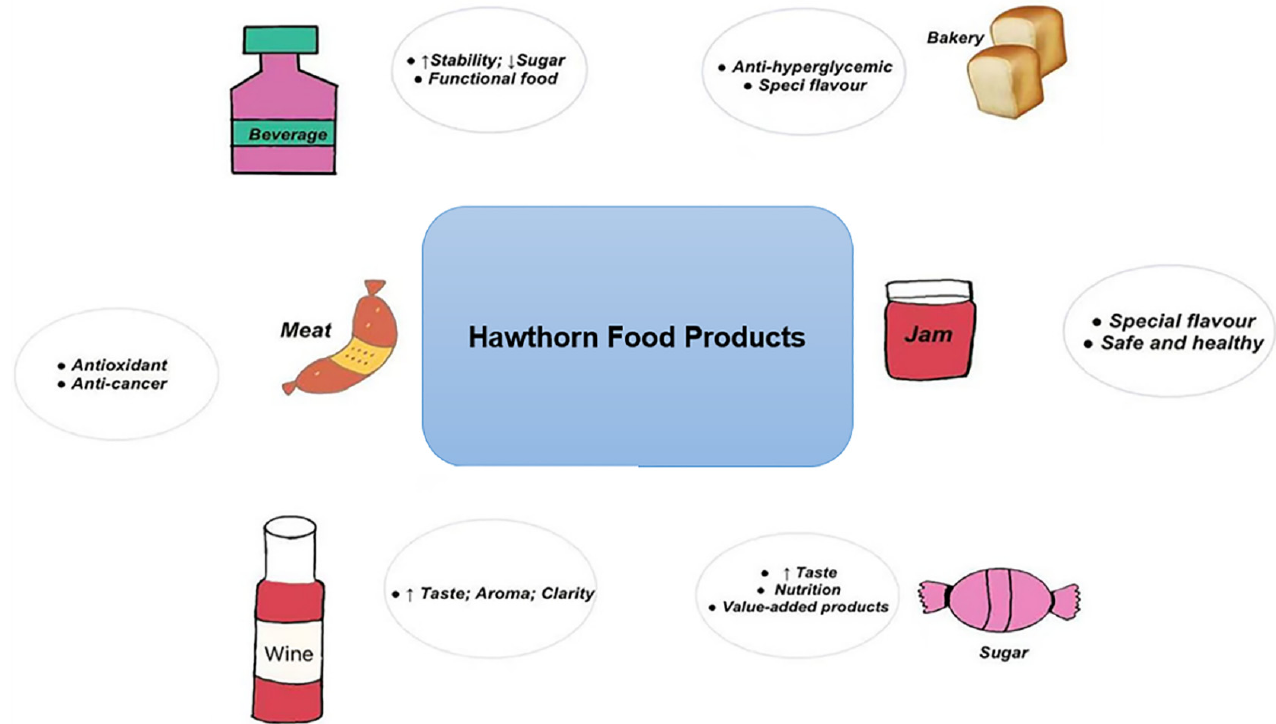
Figure 2. Modern food applications of hawthorn.